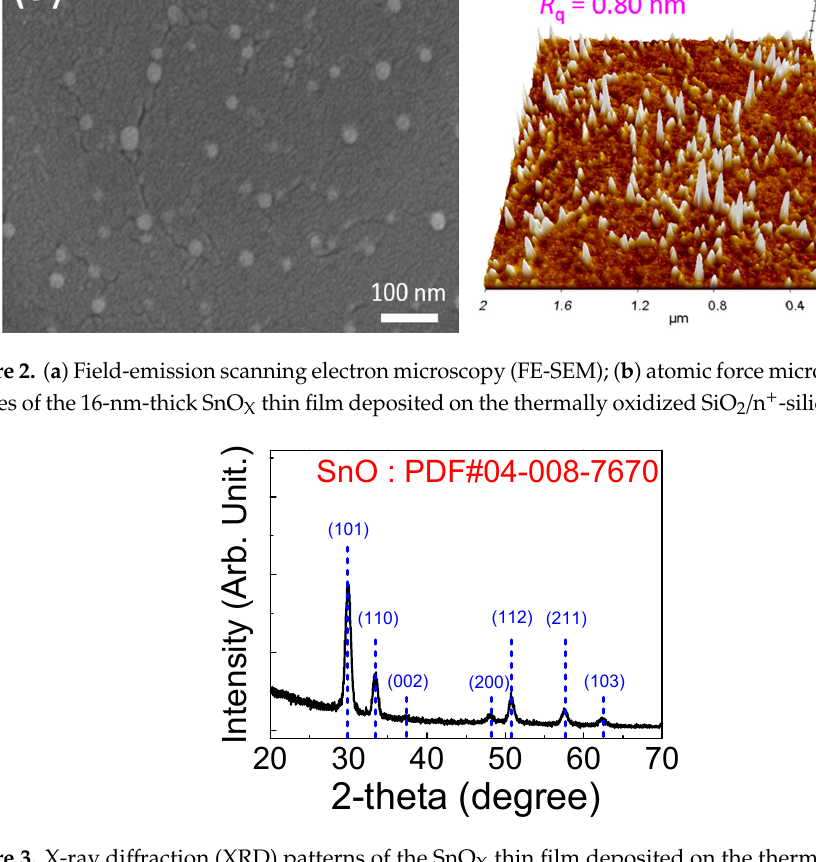
Figure 3. X-ray diffraction (XRD) patterns of the SnO X thin film deposited on the thermally oxidized SiO 2 / n + -silicon substrate.